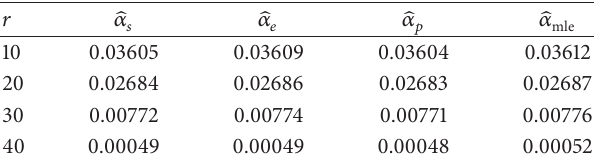
Table 1: Mean square error (MSE) of the different estimators for 𝛼